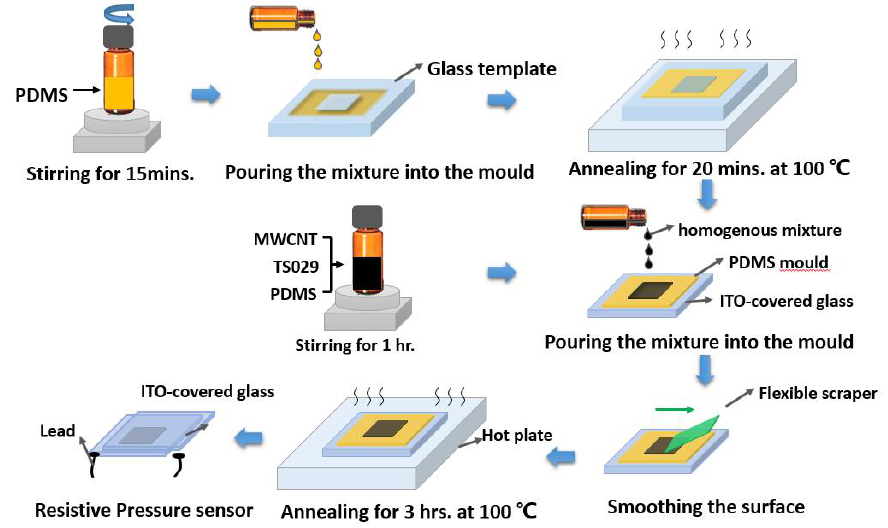
Figure 2. The fabrication process of the resistive pressure sensor.